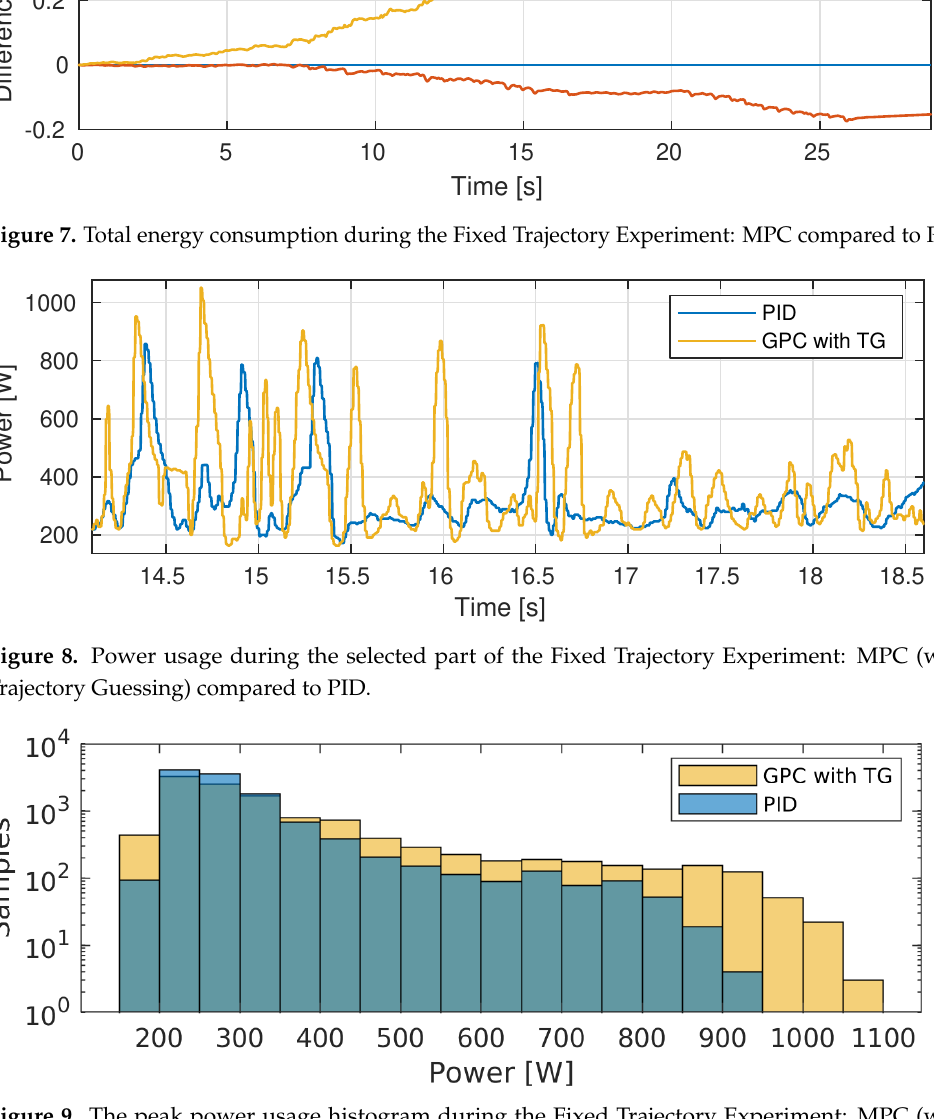
Figure 9. The peak power usage histogram during the Fixed Trajectory Experiment: MPC (with Trajectory Guessing) compared to